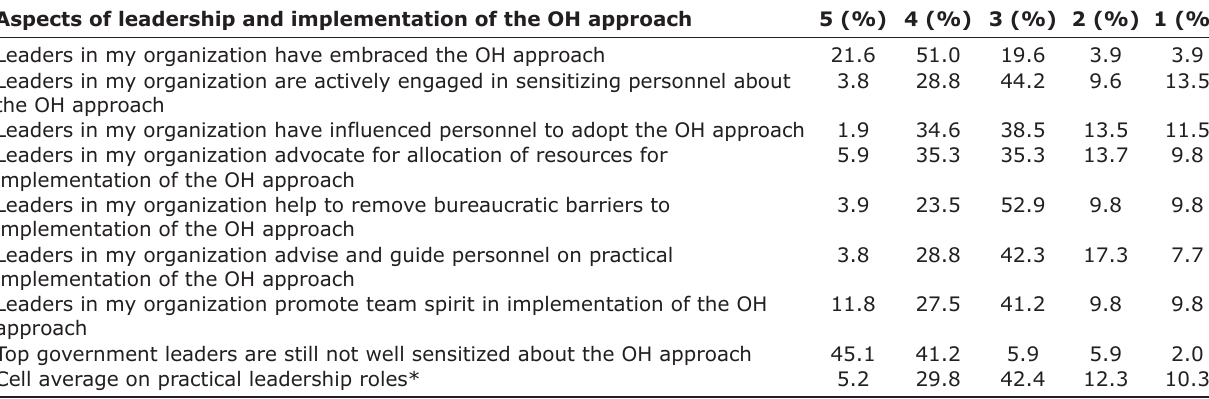
Table-8: Summary Likert scores on leadership and implementation of the OH approach. Aspects of leadership and implementation of the OH approach